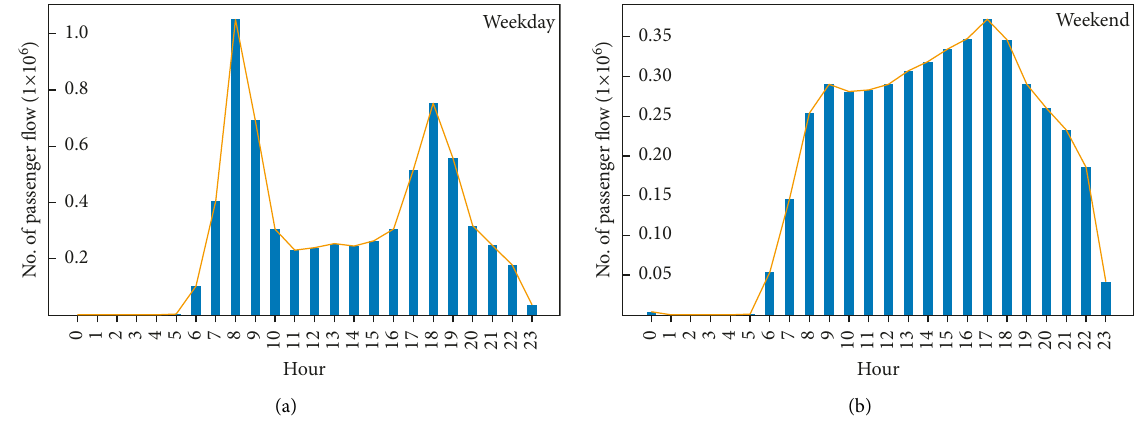
Figure 2: The temporal variation in hourly ridership of the metro network. (a) May 6 th (Weekday). (b) May 12 th